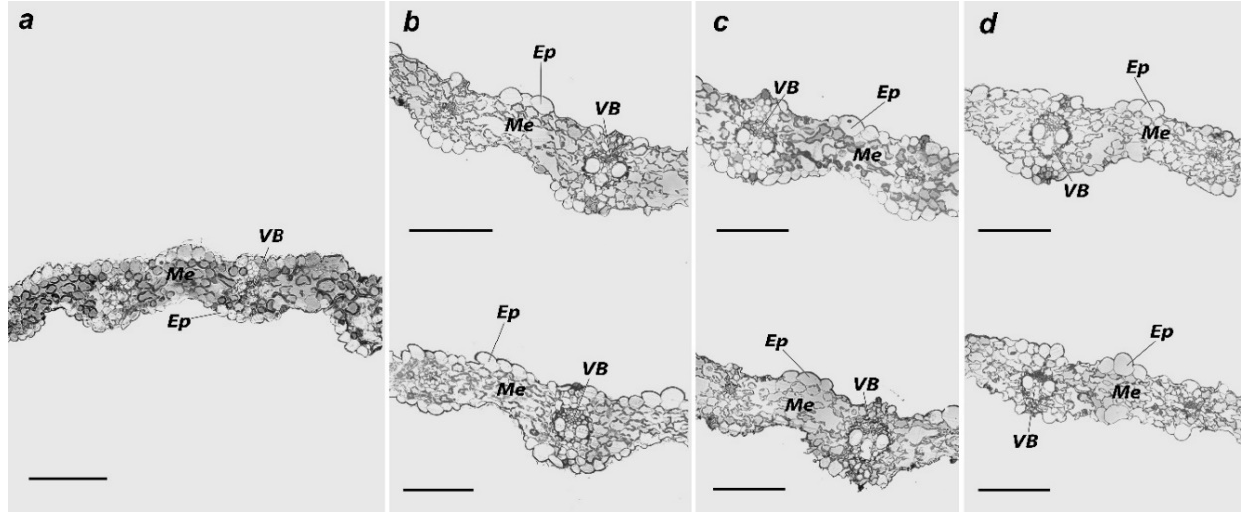
Figure 4. The cross-section of the H. vulgare leaf lamina. ( a )—control, ( b )—treatment with 440 mg/kg of Zn (top) and 1100 mg/kg of Zn (bottom), ( c )—treatment with 4 mg/kg of Cd (top) and 10 mg/kg of Cd (bottom), ( d )—treatment with combined contamination by 440 mg/kg of Zn + 4 mg/kg of Cd (top) and 1100 mg/kg of Zn + 10 mg/kg of Cd (bottom). Ep—epidermis, Me—mesophyll, VB—vascular bundle. The scale of all the sections was 100 µm. Table 3. Cytomorphometric indices of the H. vulgare leaf lamina grown on the soil at different levels of individual and combined Zn and Cd soil contamination.